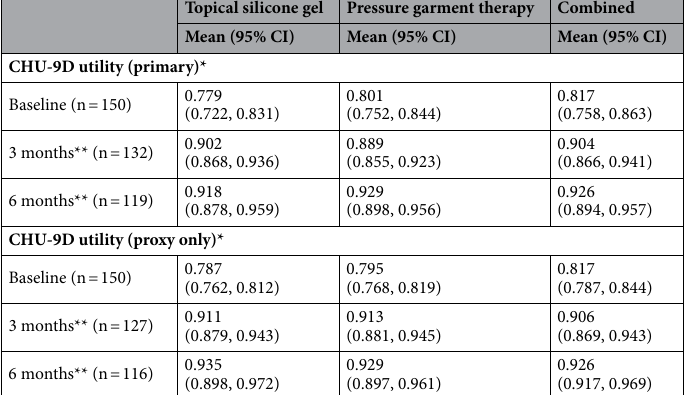
Table 1. Summary of utility values derived from the 9-item Child Health Utility (CHU-9D) instrument per group and assessment. *95% confidence intervals (CIs; bias corrected) derived from bootstrap resampling (2000 replications); **Inverse probability weighting applied to account for potential bias due to age, sex or utility (at baseline) among those retained versus lost-to-follow-up at 3 and 6